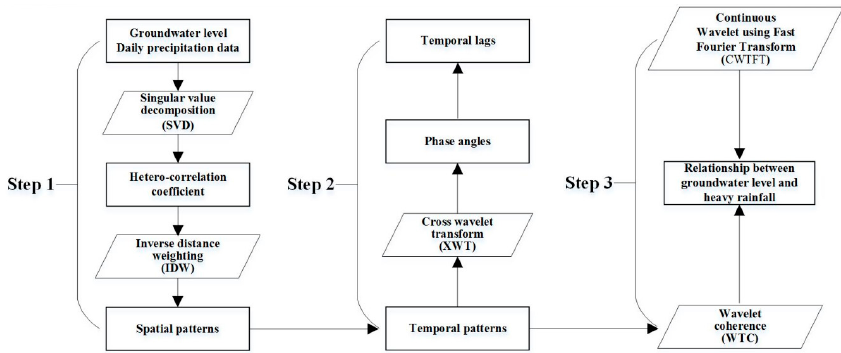
Figure 2. Conceptual framework of the research procedures conducted in this study.